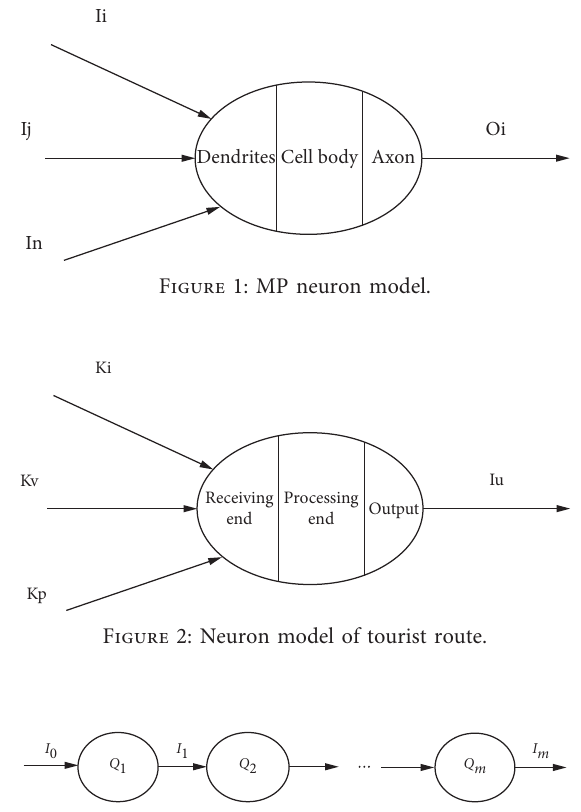
Figure 3: One-way neural chain model of tourist routes. Table 1: Scenic spot coding of scenic spot subset